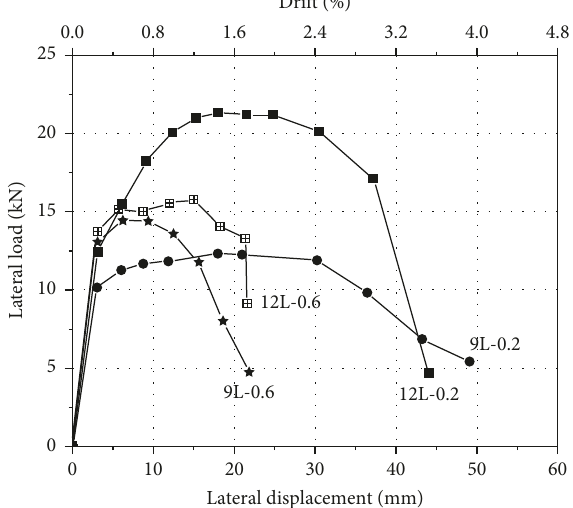
Figure 8: The envelope curve of all specimens.